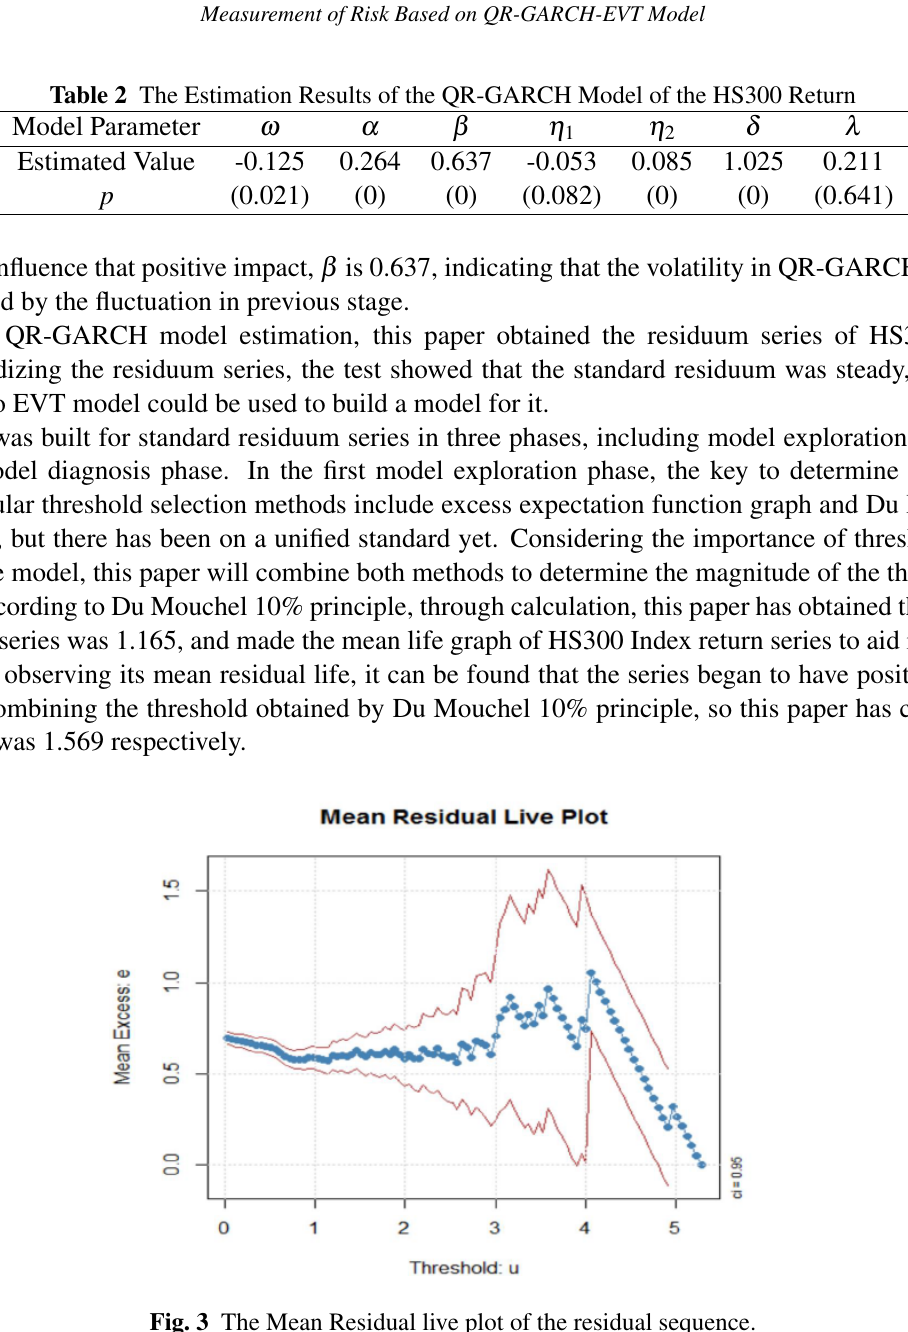
Fig. 3 The Mean Residual live plot of the residual sequence.